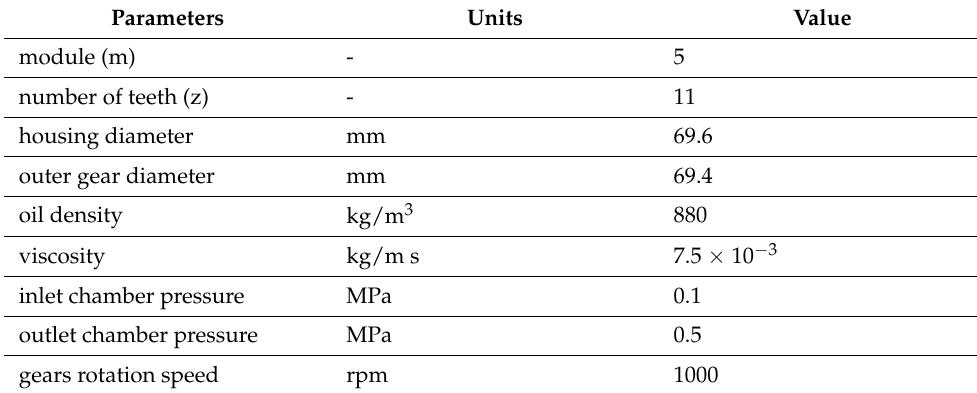
Table 1. Simulation models’ parameters.